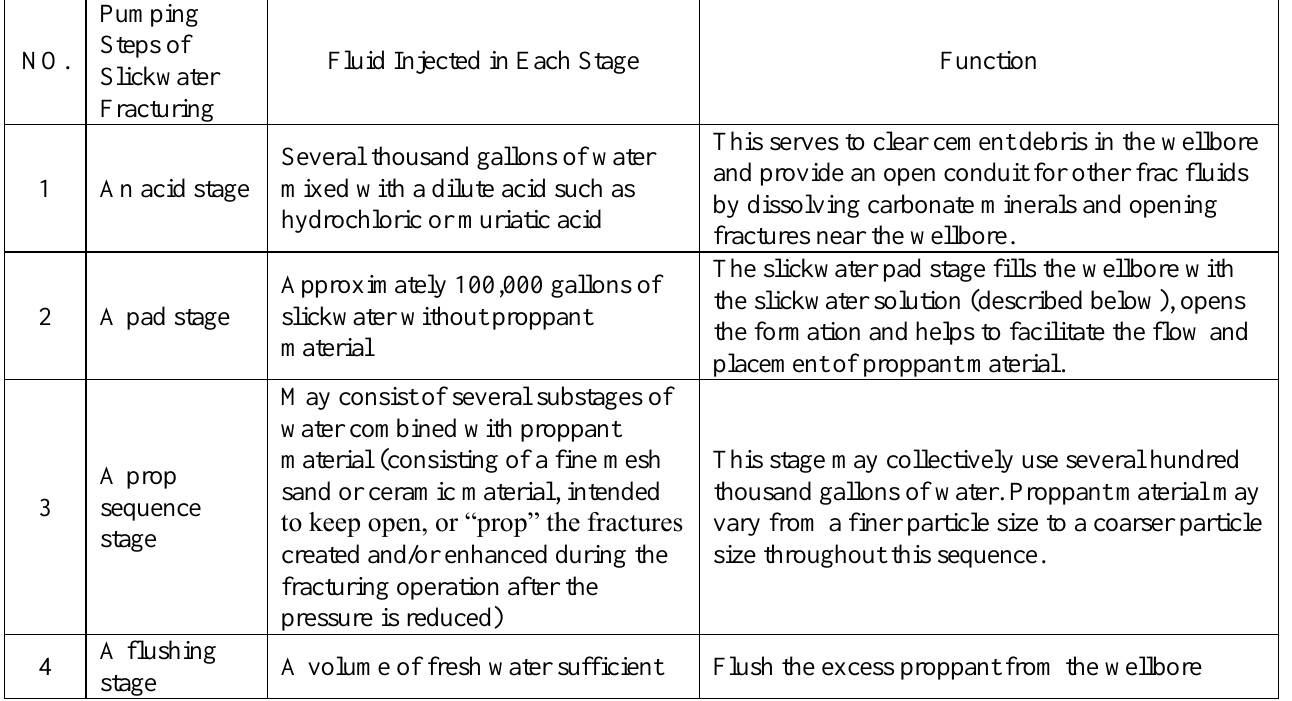
Table 3—Different stages of slickwater fracturing (Holloway and Rudd